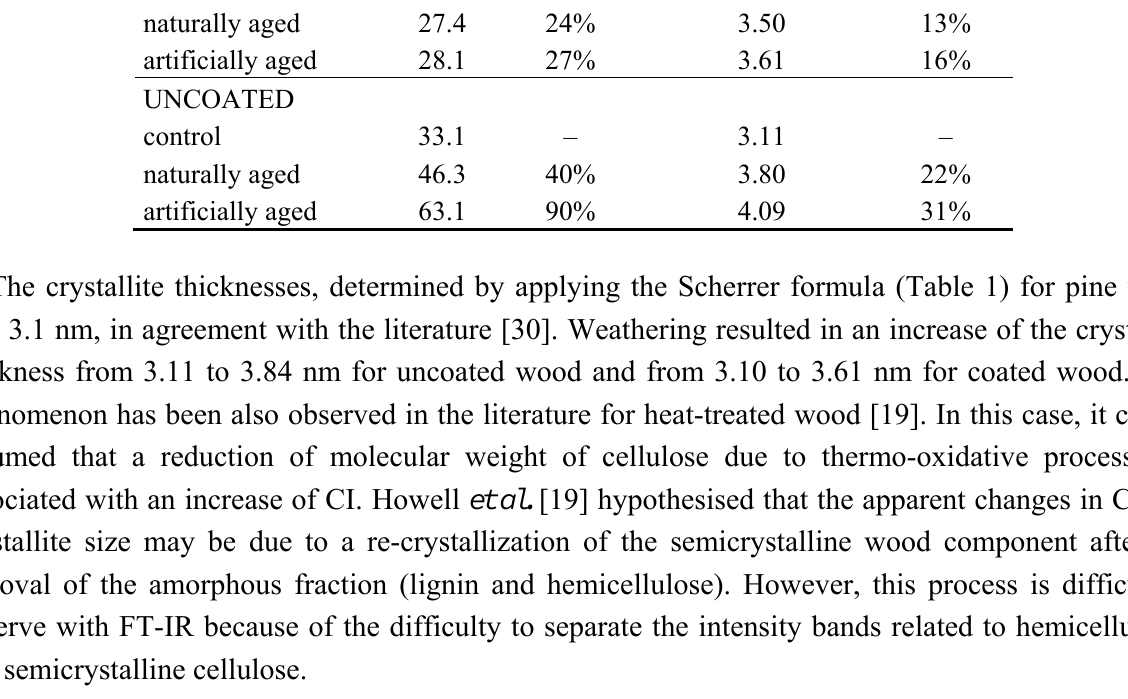
and crystallite thickness as obtained by XRD XRD